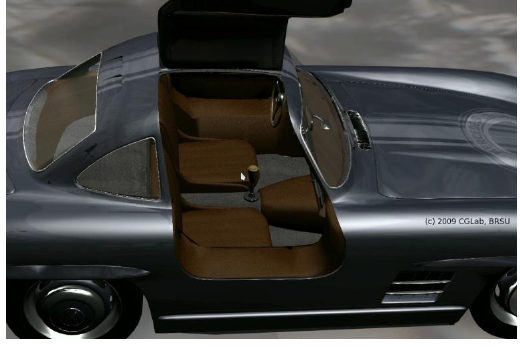
Figure 4. TraCell: interactive global illumination of a car model